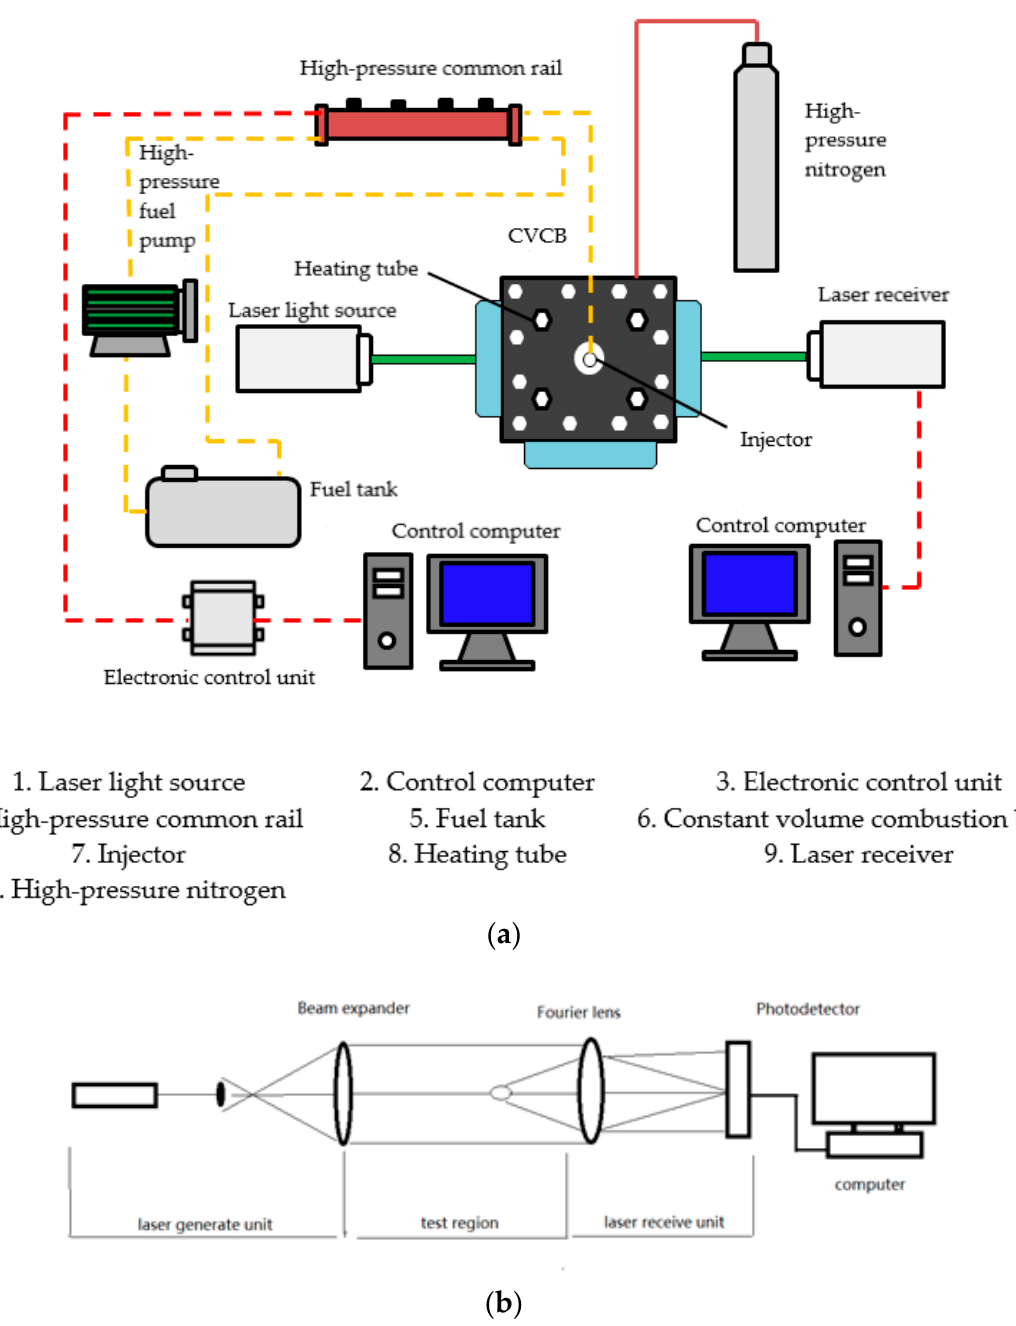
Figure 3. ( a ) Micro experimental test structure diagram. ( b ) Working principle of Winner 318A.